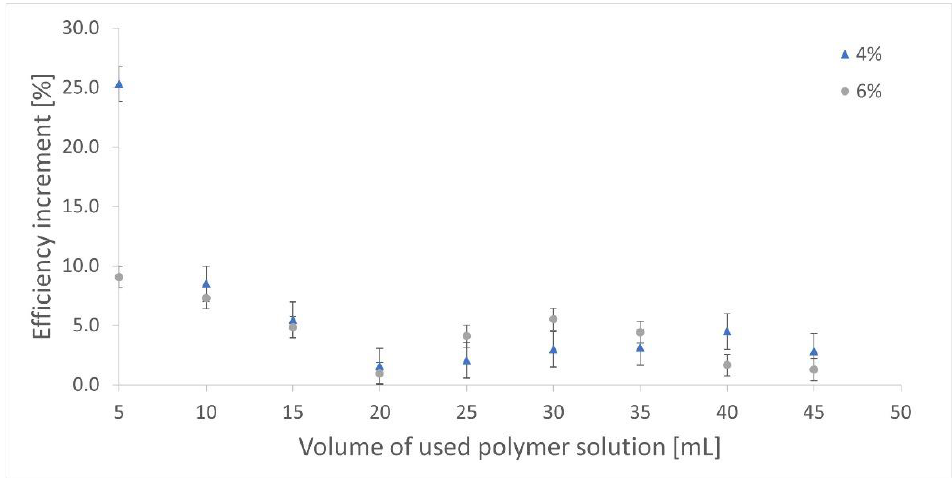
Figure 12. Overall filtration efficiency increments as a function of the polymer solution’s volume.